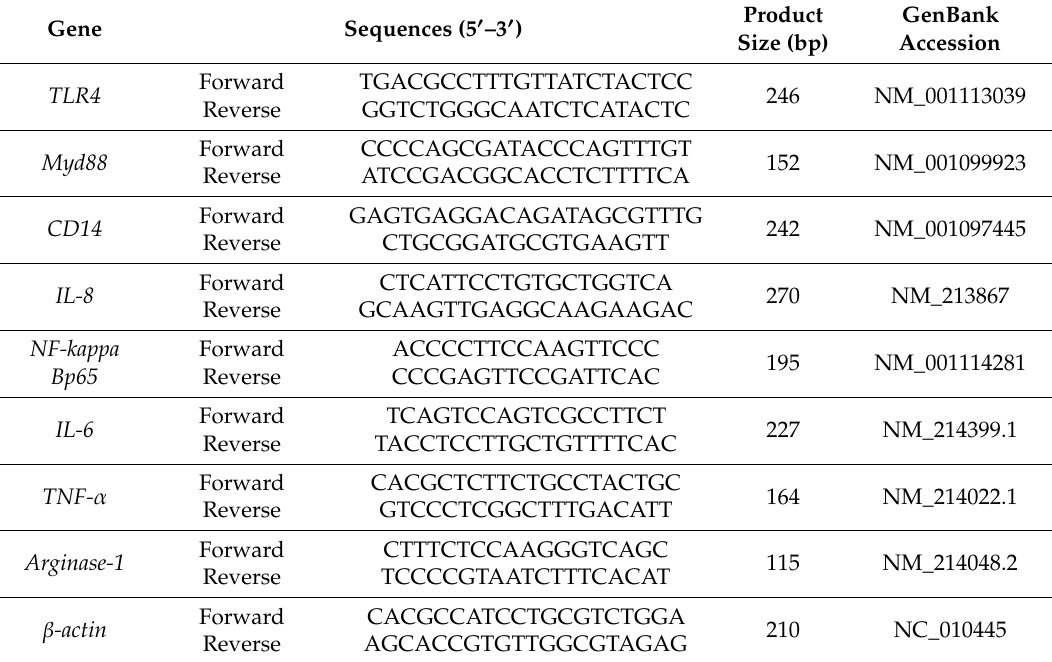
Table 1. Primer sequences used in this